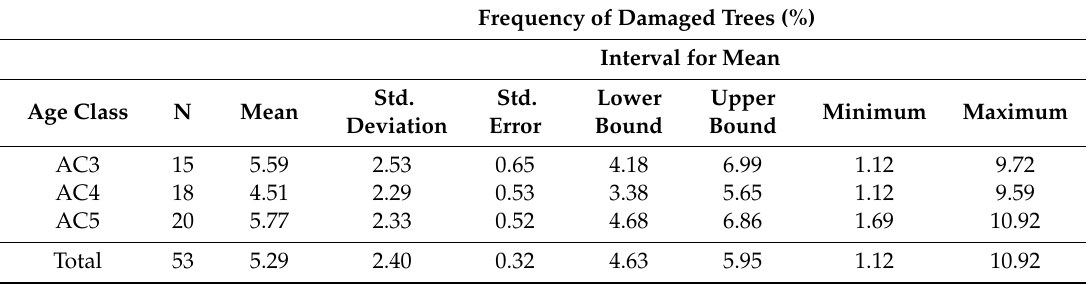
Table 3. Frequency of damaged trees with respect to age class